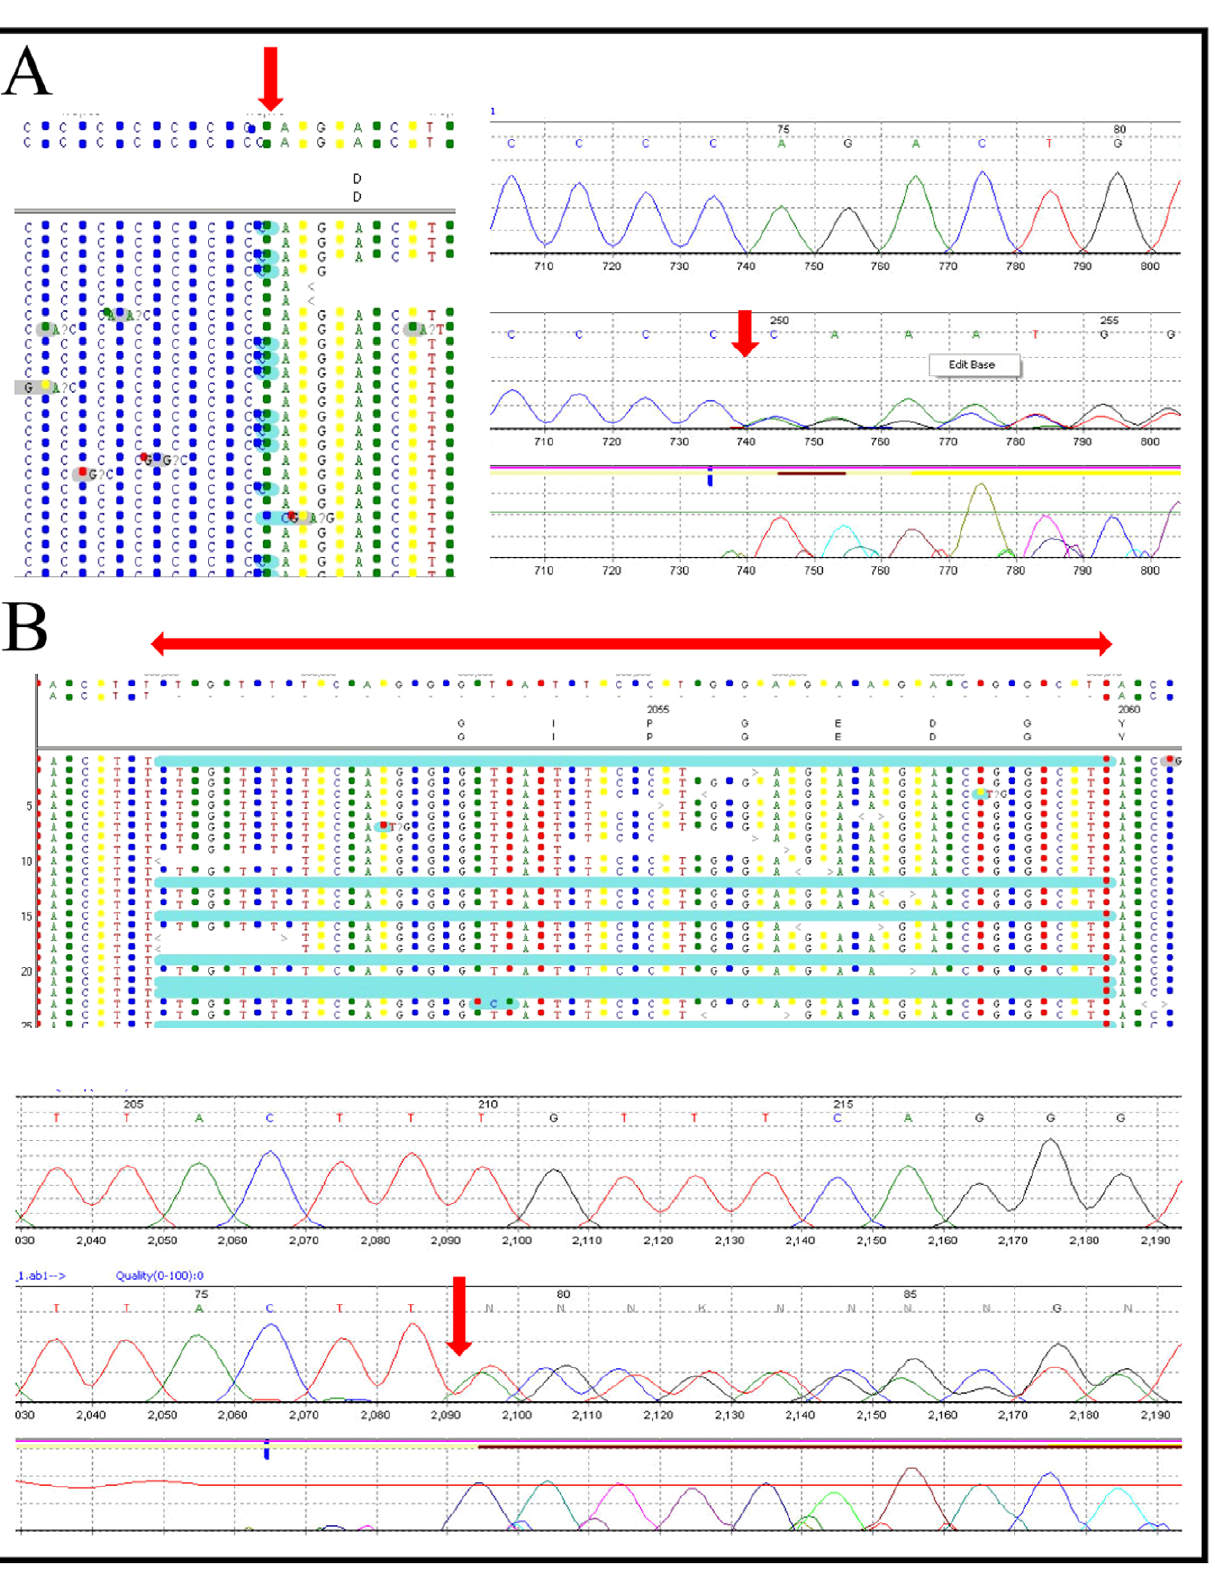
Figure 1. Variant detection by NGS (top) and Sanger sequencing confirmation (bottom). ( A ) Example of an insertion mutation: IVS15-3- 2insC in COL6A2 identified byNGS (to the left) and confirmed by Sanger sequencing (to the right). ( B ) Example of a 30-bp deletion: IVS16-8del30 in COL6A3 as represented by NGS analysis (top panel) and Sanger sequencing (bottom panel). The exact site or representation of the mutation is indicated by the red arrowheads. doi:10.1371/journal.pone.0053083.g001 PLOS ONE |